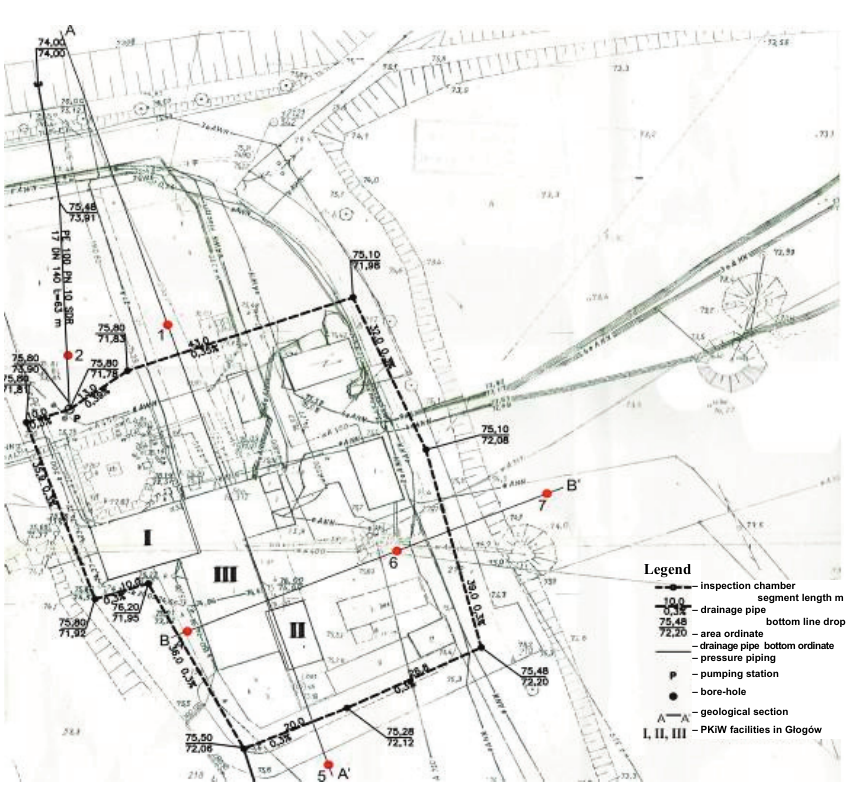
Fig. 4. Draining by means of a non-deepened drainage – variant